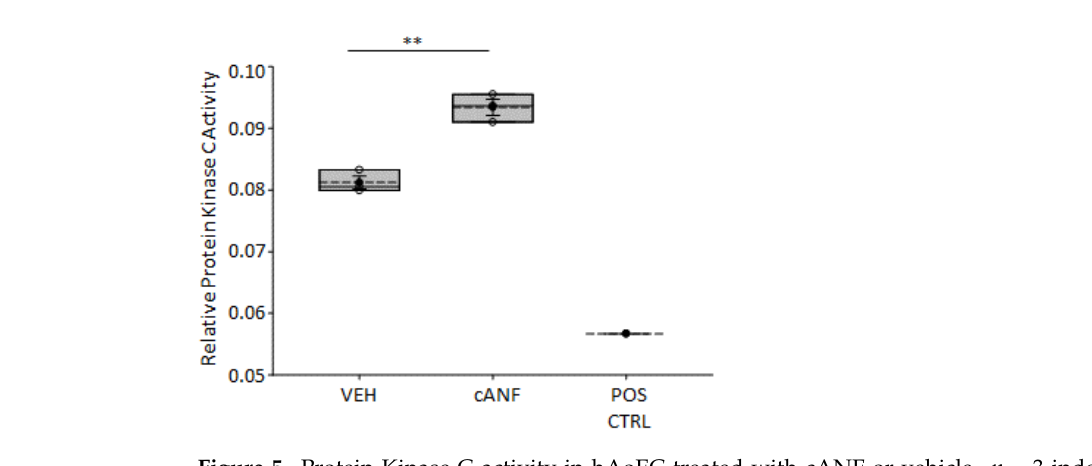
Figure 5. Protein Kinase C activity in hAoEC treated with cANF or vehicle. n = 3 independent cANF versus vehicle (VEH) control treatment experiments. POS CTRL represents Positive Control. A Student’s t -test was performed to make comparisons between the two groups. n = 3 samples for each of the two groups. ** Represents a p -value < 0.01.